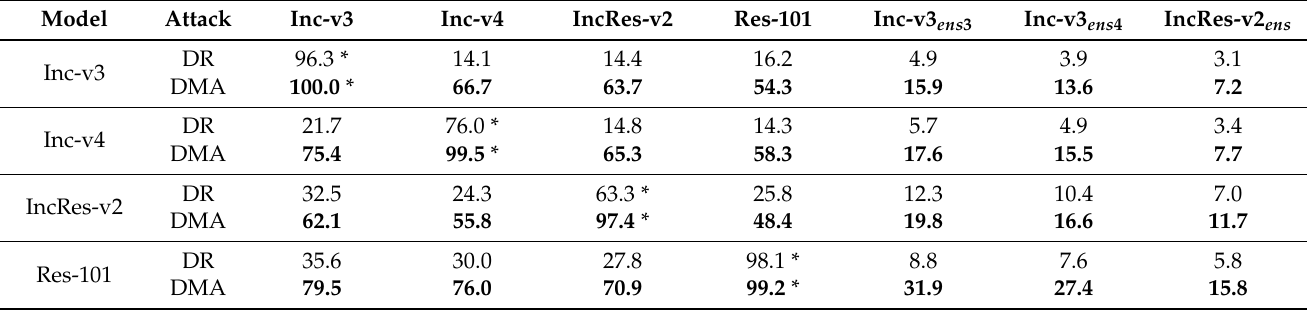
Table 3. The success rates of DR and DMA. The adversarial examples are crafted for Inc-v3, Inc-v4, IncRes-v2, and Res-101, respectively. * indicates the white-box